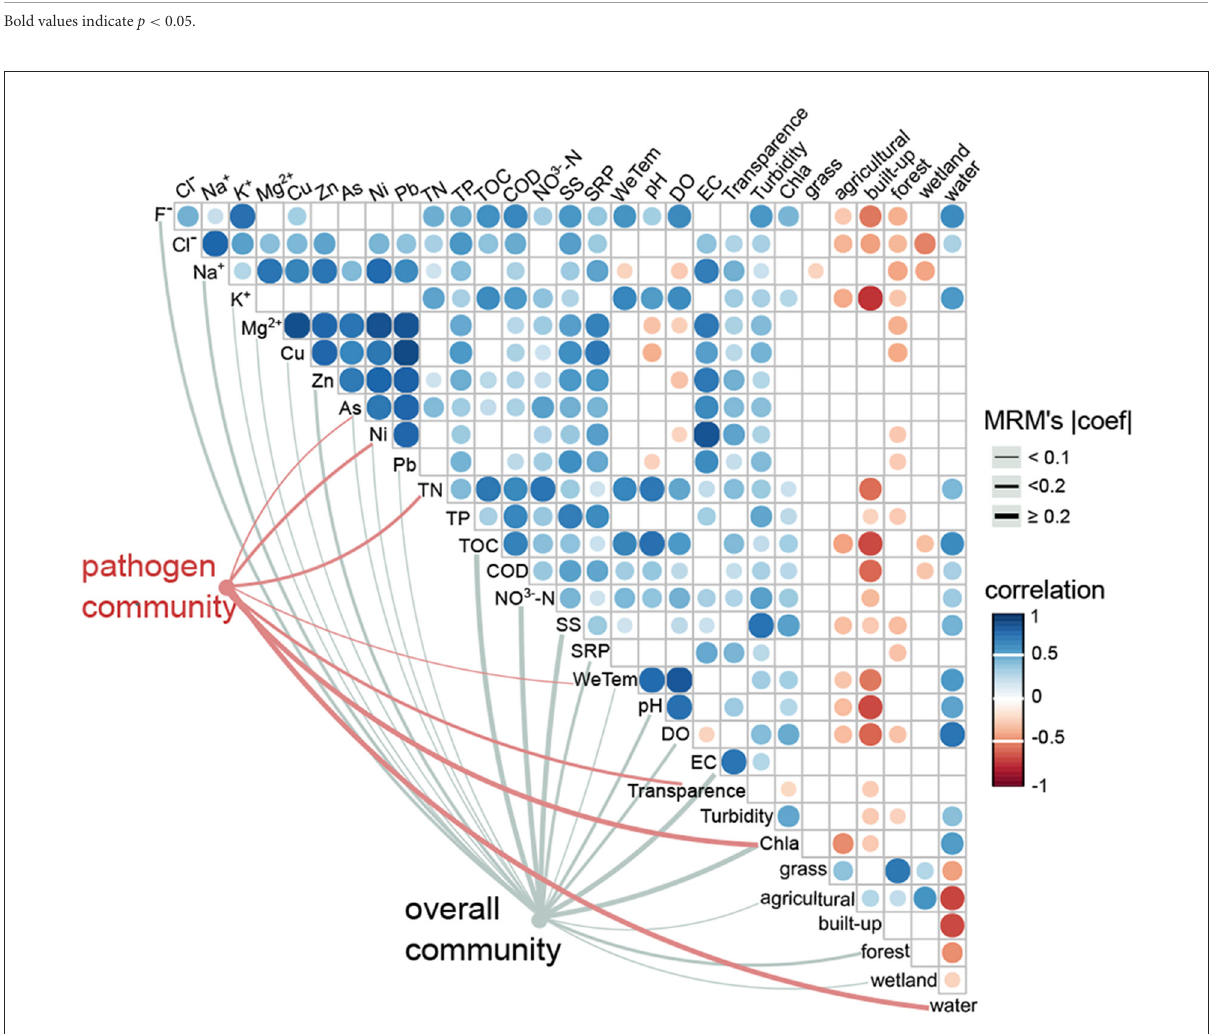
FIGURE6 Effects of environmental drivers on the pathogen community and the overall community. The associations between environmental variables and the pathogen community (red edges) and the overall community (gray edges) were tested by MRM models ( p < 0.05). The edge width corresponds to the MRM’s coefficient. The color gradient indicates Spearman correlations among environmental variables ( p <